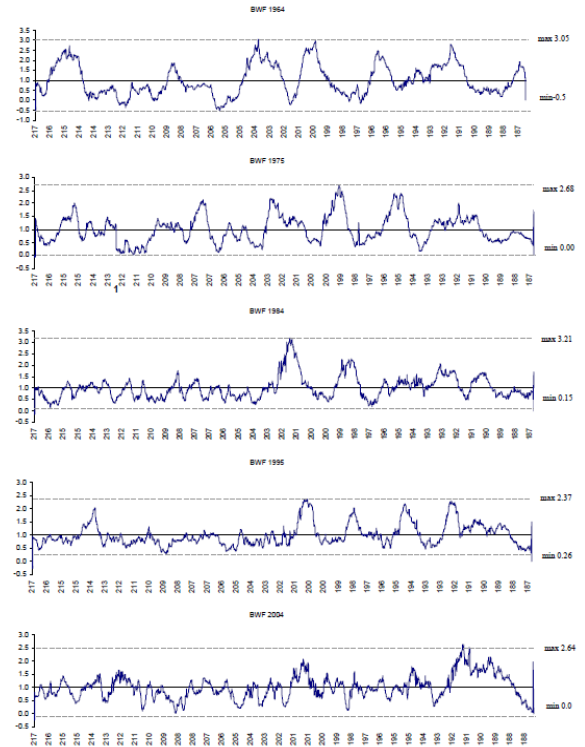
Figure 4. Beach width factor in successive years from 1964 to 2004 in the examined Baltic Sea